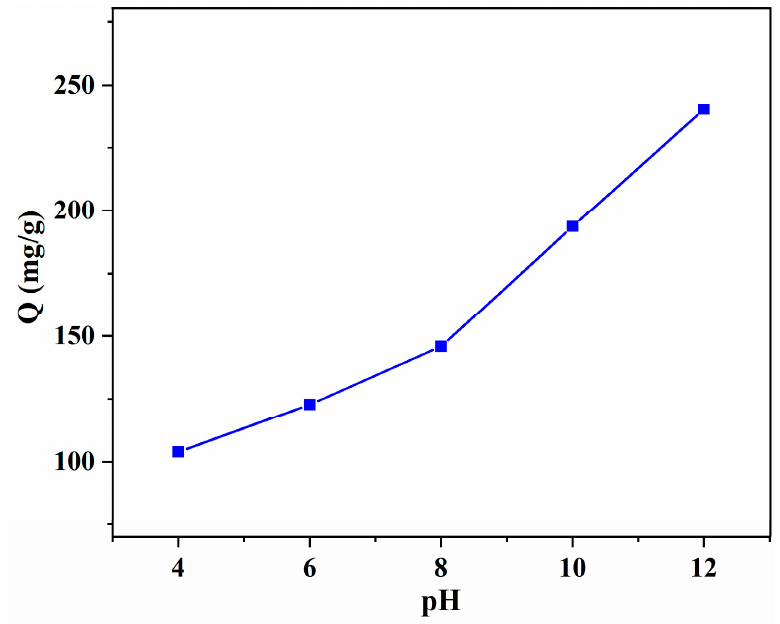
Figure 5. Effect of the pH value on the adsorption capacity with SA/Lig-20% beads ( m = 20 mg, C 0 = 200 mg/L, V = 30 mL, T = 25 °C, s = 150r/min, t = 4 h).